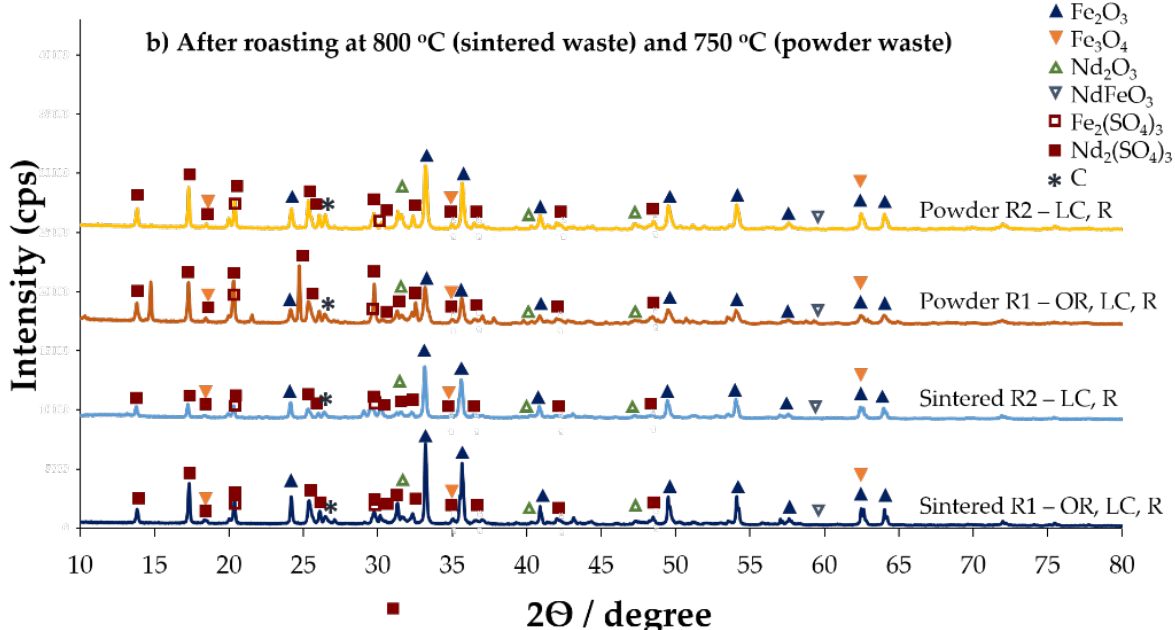
Figure 8. An XRD analyses of the products from route 1 oxidative roasting—selective leaching and route 2 whole leaching, ( a ) after leaching and drying, and ( b ) after roasting. Note: OR: oxidative roasting, LC: leaching and R: roasting.